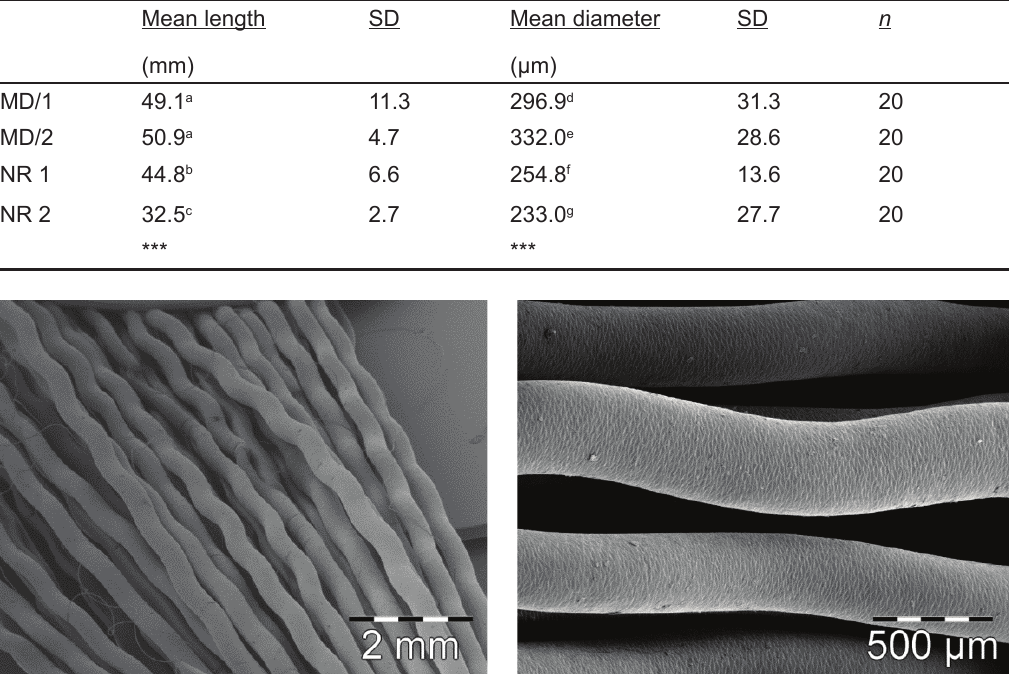
Table 1. Length and diameter of guard hairs from the back of the winter pelage of two musk deer (MD/1 and MD/2) and two adult female reindeer (NR1 and NR2). Column values within species bearing the same suffix letter are not significantly different ( P >0.05); differences are significant at P <0.001. *** indicates a significant difference between species ( P <0.001); n = the number of hairs from each animal.